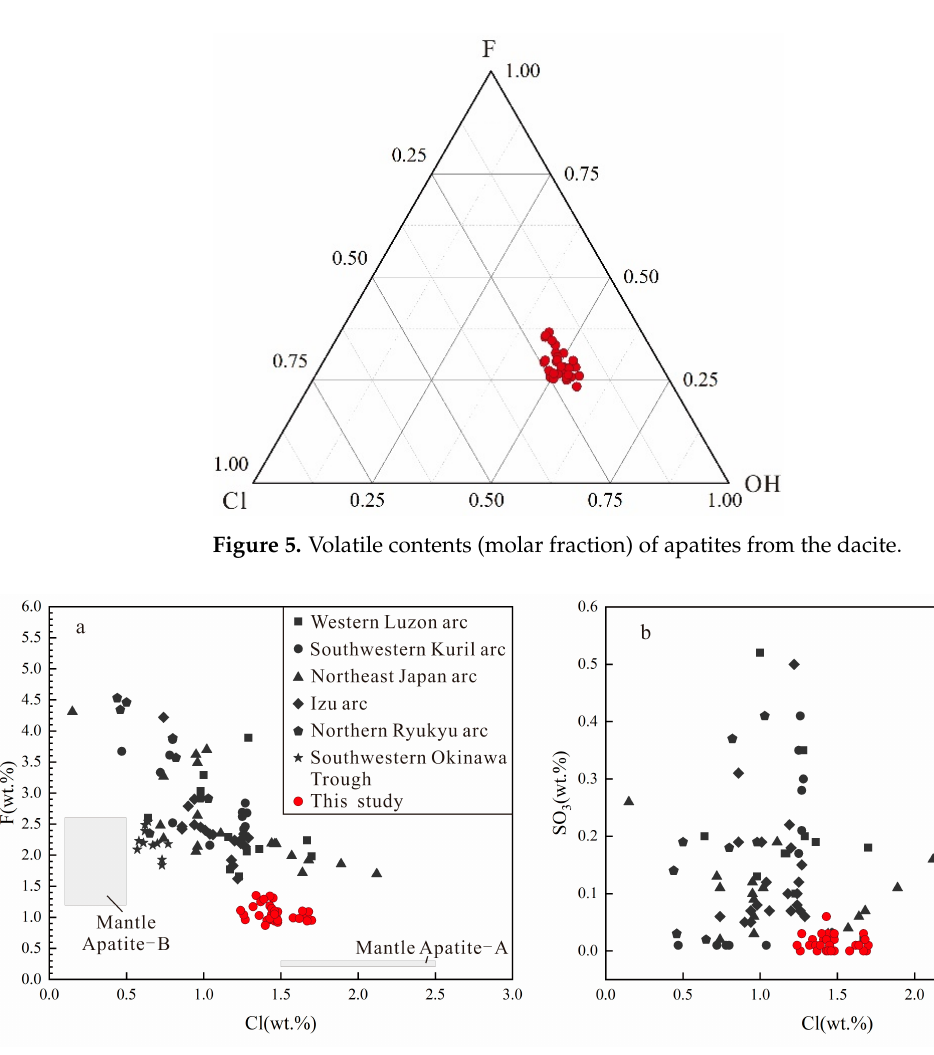
Figure 4. Plots of MnO versus SiO 2 in apatites of dacite ( modified from ref. [46]).